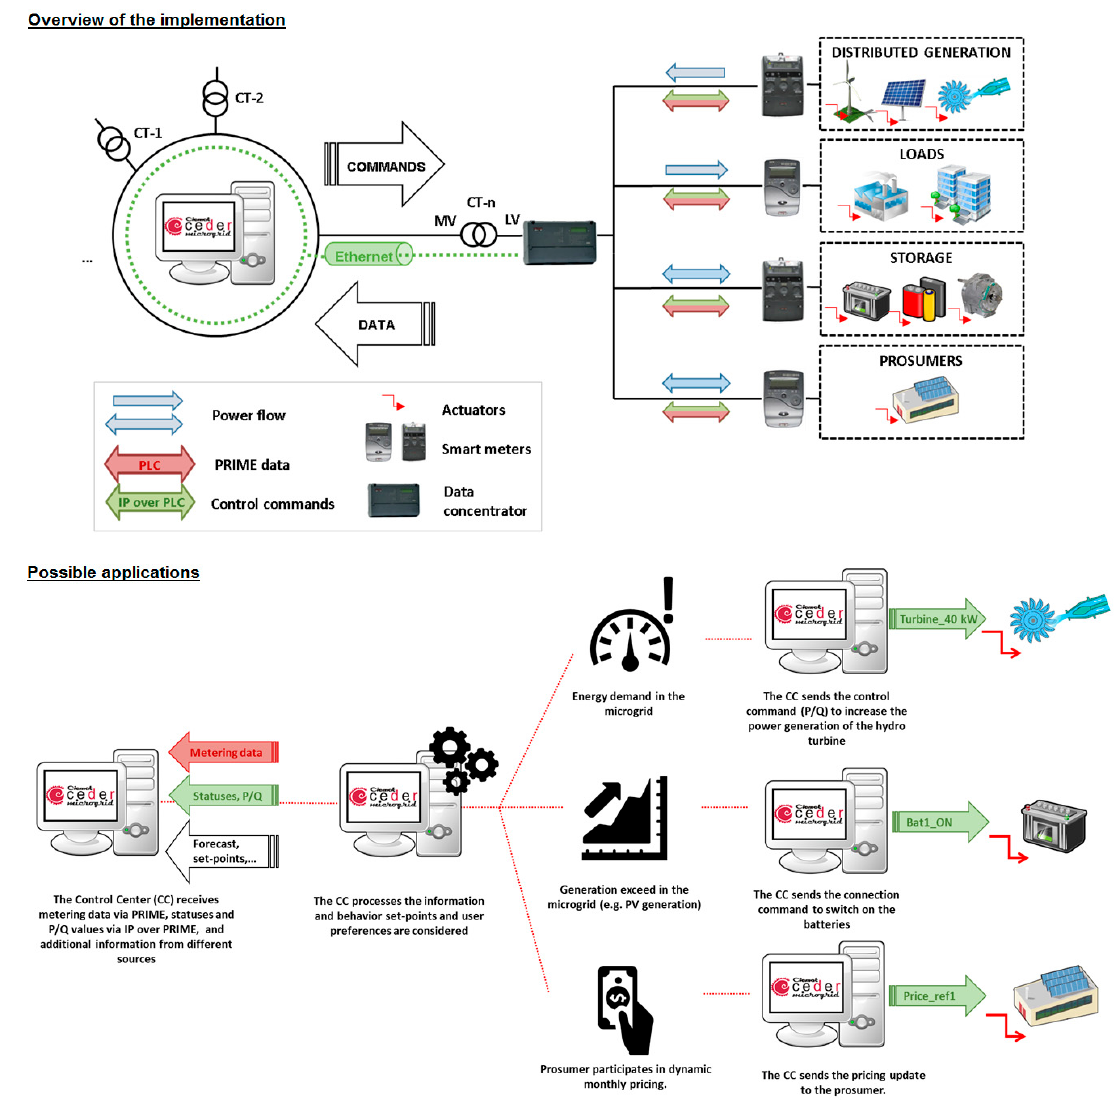
Figure 3. Proposed scheme for including additional tasks in a microgrid with the implementation of IP over PLC-PRIME: IP-based control commands are sent from the grid operator via Ethernet to the data concentrator, in which IP data is encapsulated into PLC-PRIME frames towards the receiver node. Once the frames arrives at the destination, the data is conveniently interpreted by an actuator which acts over the desired distributed energy resources (DER). IP-based status information from the DERs travels in reverse, towards the operator via the data concentrator. Additionally, three possible applications are depicted: P/Q commands, remote connection/disconnection, and payment